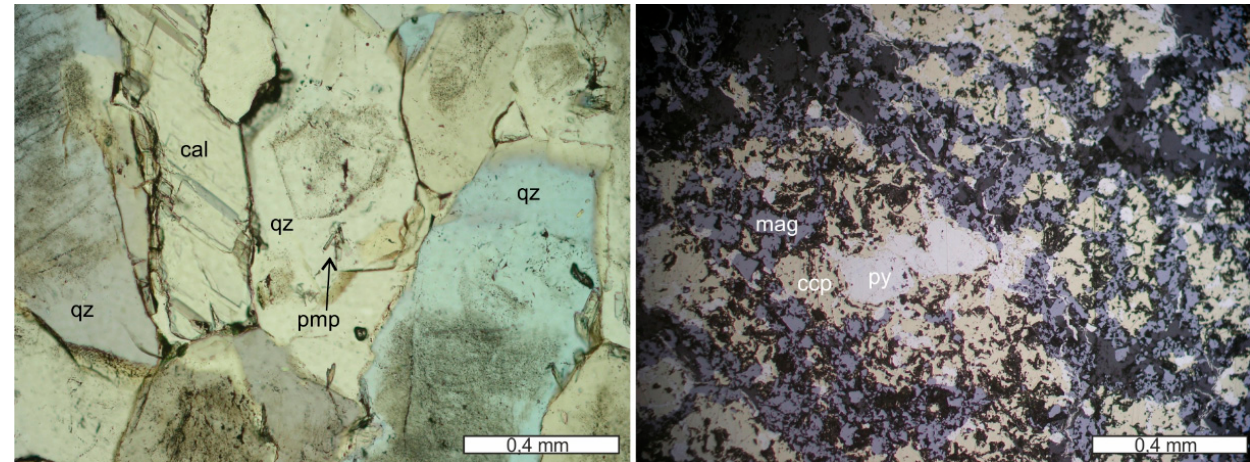
Figure 3. Coarse-grained early quartz (qz) (at places with growth zones with primary fluid inclusions),